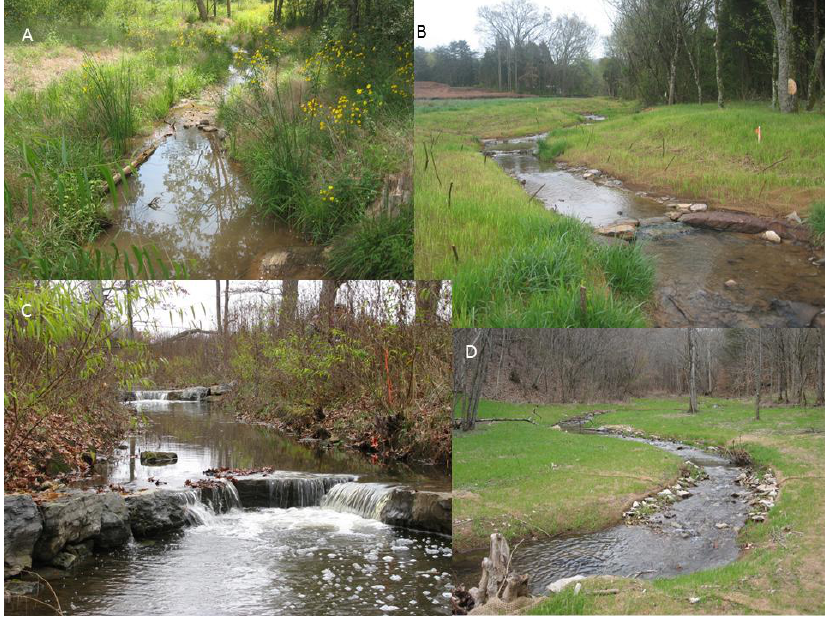
Figure 4. Structures used for stream restoration. A . A small log vane is used to stabilize the bank immediately upstream of a small constructed riffle. B . Cross-vanes are used for bed stabilization. Newly planted willow stakes line the bank and constructed